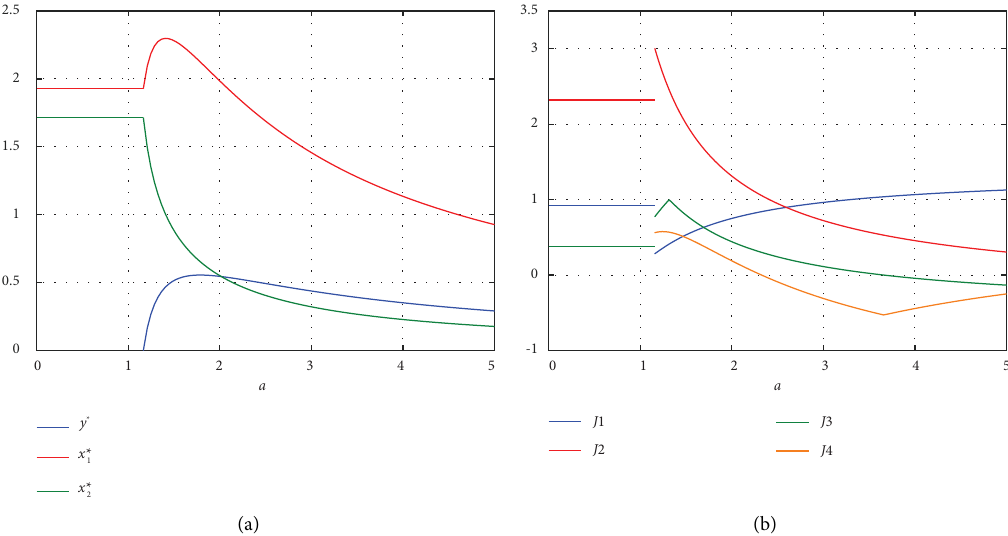
( a ) , ... , J ( a ) , map (37). Parameter 1 4